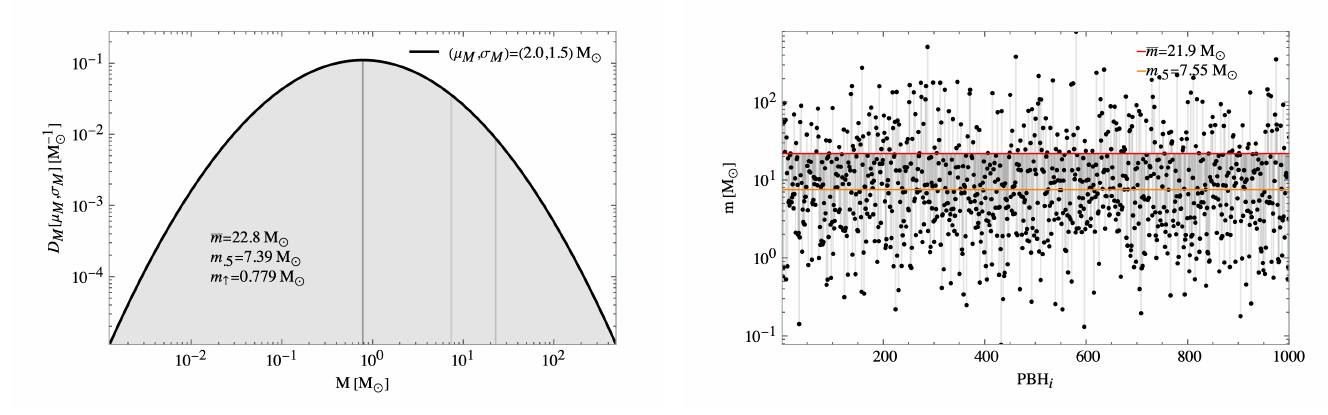
Figure 2. Mass IC profile from Table 1 and an example realisation, from the logarithmic mean µ m = 2.0M (cid:12) and deviation σ m = 1.5M (cid:12) . The thick, normal and thin grey lines signal the distribution mode, median and mean, respectively. The orange and red lines signal the realisation median and mean, respectively. Note the large hierarchy between modal, median and mean masses due to the large m → ∞ tail of the distribution, skewing the mean to large values, which results in a large variance of the total mass per realisation. The total mass is m tot = ∑ i m i = ∑ i ( m i ) = 2.19 × 10 4 M (cid:12)